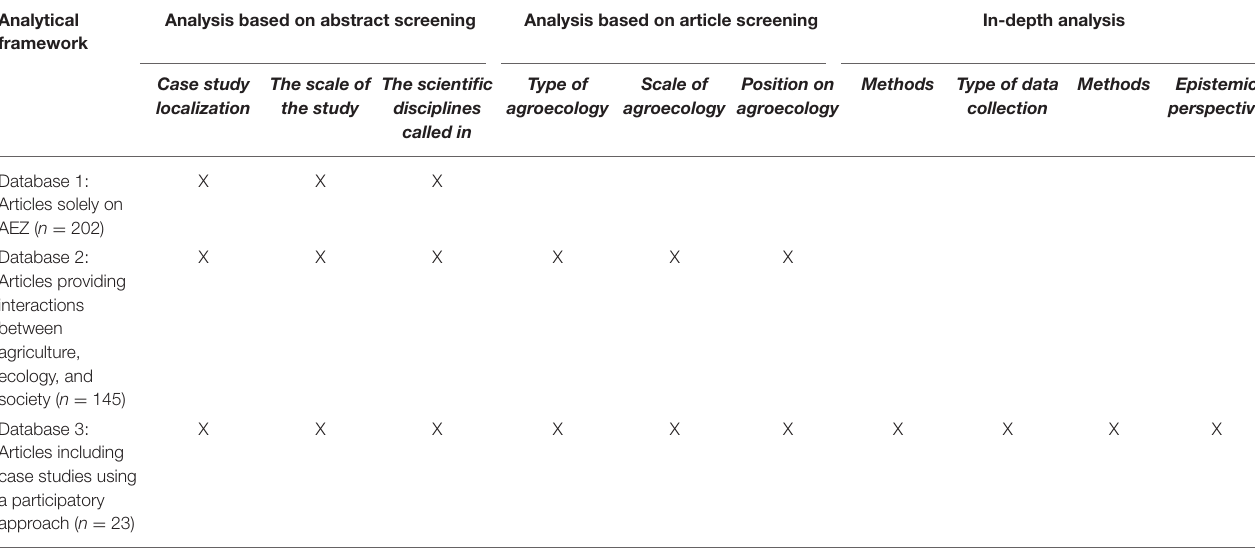
TABLE 2 | The analytical framework for analyzing extracted articles.